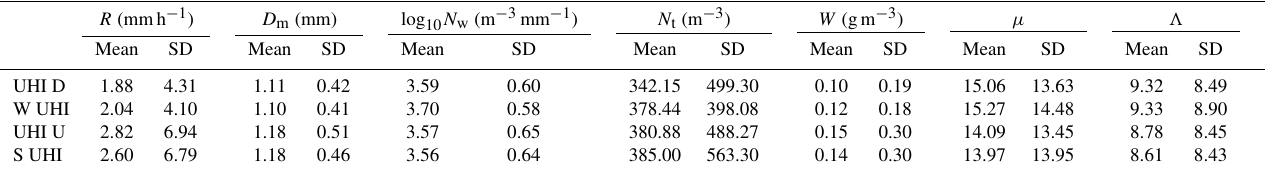
Table 5. Mean and standard deviation (SD) values of R , D m , log 10 N w , N t , W , µ , and (cid:51) for different diurnal periods based on UHI intensity.